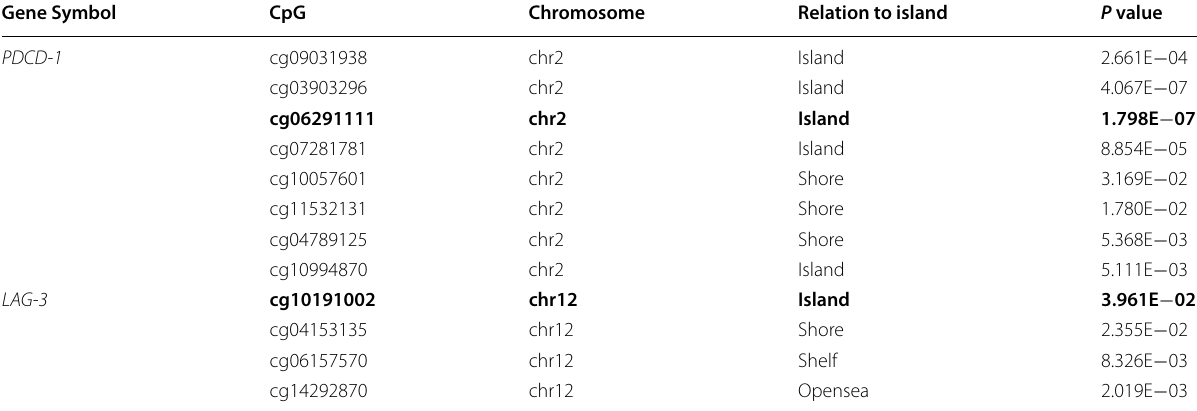
The final screened CpG sites were indicated in bold